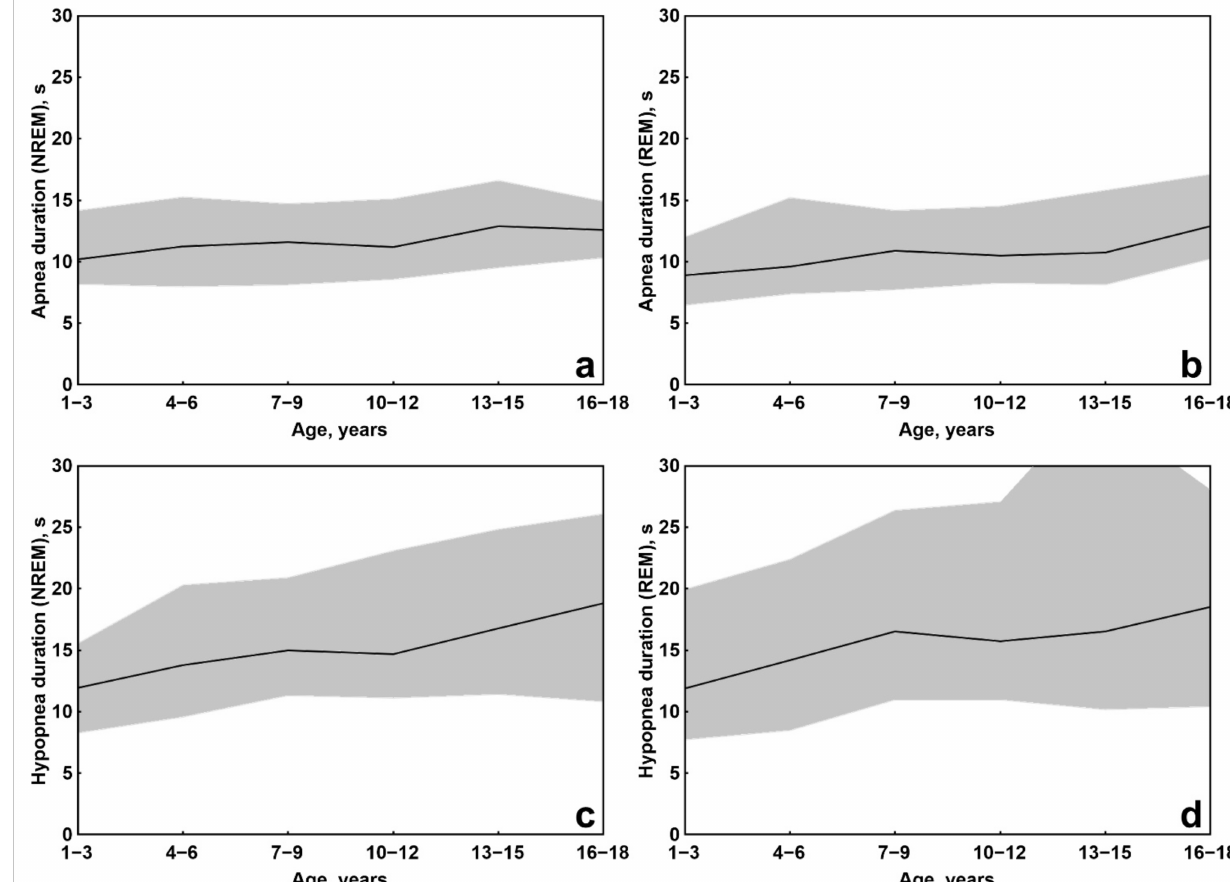
Figure 3. Median (continuous line) and the interval between the 5th and 95th centiles (grey-shaded area) of apnea duration during NREM ( a ) and REM sleep ( b ) and hypopnea duration during NREM ( c ) and REM sleep ( d ) in different age